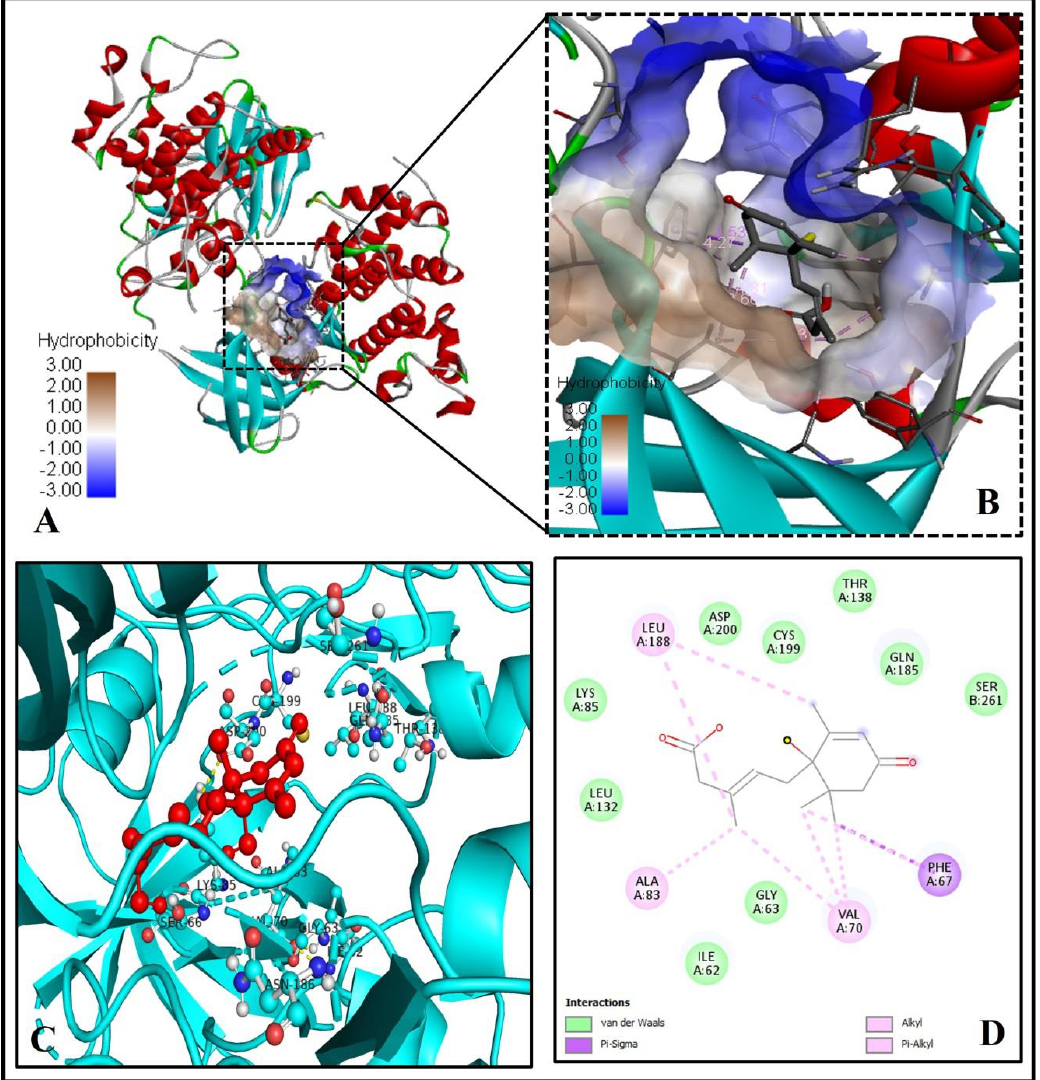
Figure 8. ABA shows mild interaction with human GSK3 (PDB ID: 3FZ7). ( A ) The ABA binds to the binding pocket near the catalytic center. ( B ) An enlarged image is showing the hydrophobicity of the binding cavity ’ s amino acid residues. ( C ) The 3D picture reveals substantial interactions (yellow dashed lines) of ABA (red ball and sticks) with human GSK-3 residues (cyan ball and sticks). ( D ) The molecular level interactions of binding pocket residues with the ABA are depicted in the 2D plot.